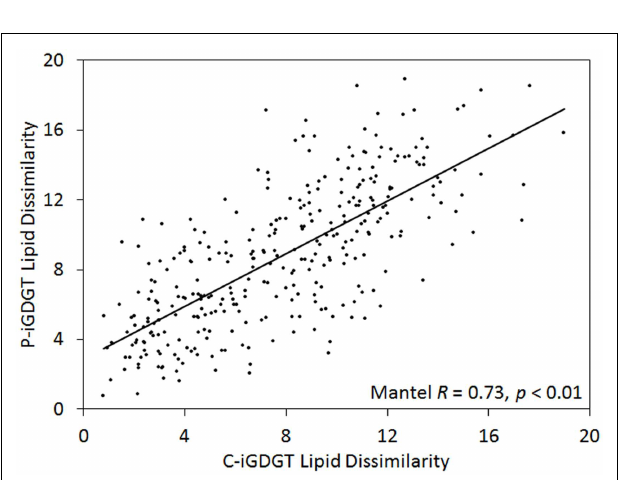
FIGURE 2 | Mantel regression of matrices describing the dissimilarity in the composition of 26 geothermal spring sediment/mat C-iGDGTs and P-iGDGTs. The relative abundances of individual lipids used to construct the matrices are presented in Tables 2 and 3